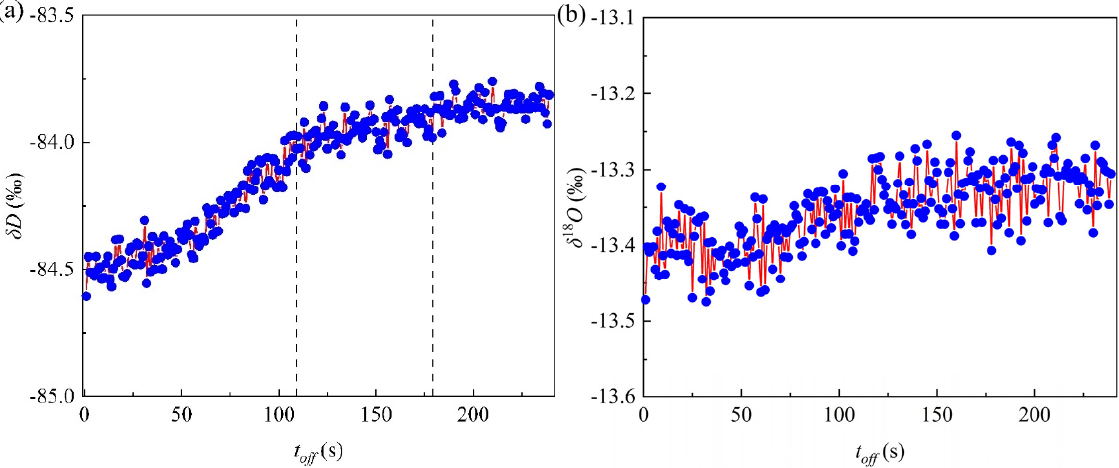
Figure 5. The ( a ) δ D and ( b ) δ 18 O value temporal variations in environmental water vapor after the acoustic waves operation was stopped.